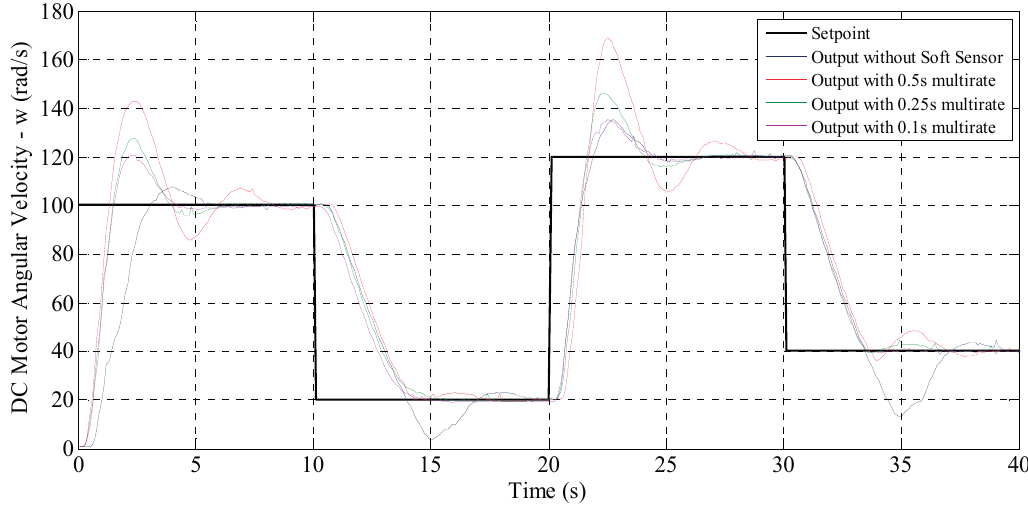
Figure 5. Comparison between the WNCS responses: wireless sensor with real sampling period of 1 s and soft sensor with virtual data sampling periods of 0.5, 0.25 and 0.1 s.